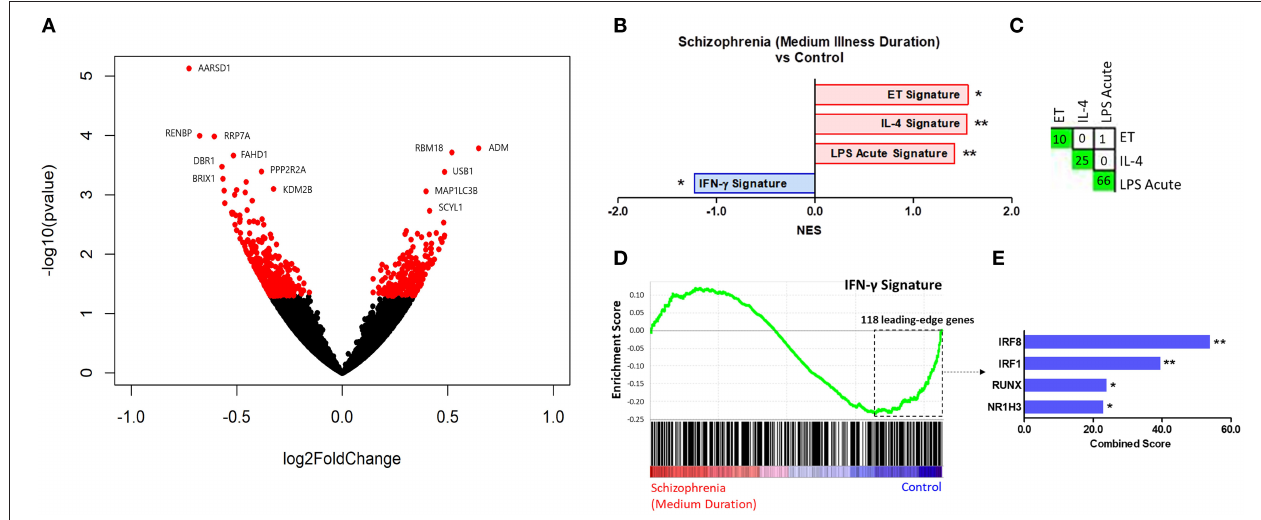
FIGURE 3 | (A) Volcano plot of DGE: medium illness duration vs. controls. p < 0.05 labeled red. (B) Signatures that were enriched in the medium illness duration group compared to controls. **FDR < 0.05, *FDR < 0.25. (C) Leading-edge analysis for signatures enriched amongst genes increased in the medium illness duration group compared to controls. The number and green gradient indicate overlapping leading-edge subset genes between the corresponding signatures. (D) Enrichment plot for the IFN- γ signature in the medium illness duration group compared to controls. Genes are ranked from greatest increase to the greatest decrease in expression in the medium illness duration group compared to controls. Black lines indicate the location of genes that are in both the ranked list and gene set. (E) Top four results from the TFEA of the leading-edge subset genes in the IFN- γ signature. ** p < 0.001 and adjusted p < 0.001, *adjusted p < 0.01.